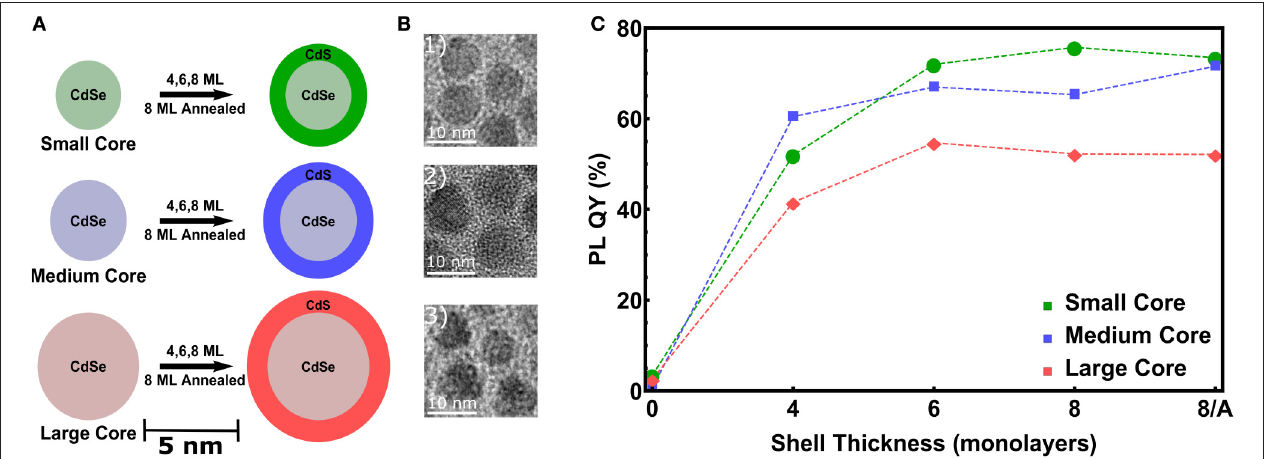
FIGURE 1 | (A) Scheme of the used CdSe cores dimensions denoted as small ( D core = 3.6 nm), medium ( D core = 4.4 nm) and large ( D core = 5.7 nm). On top of these cores 4, 6, and 8 ML of CdS are grown. For the thickest shell an additional annealing step at 310 ◦ C is performed for the medium and large samples. (B) TEM images of the CdSe/CdS core/shell NCs with the thickest shell of 8 ML. (C) Photoluminescence quantum yield (PL-QY) as a function of the intended shell thickness for all three sample